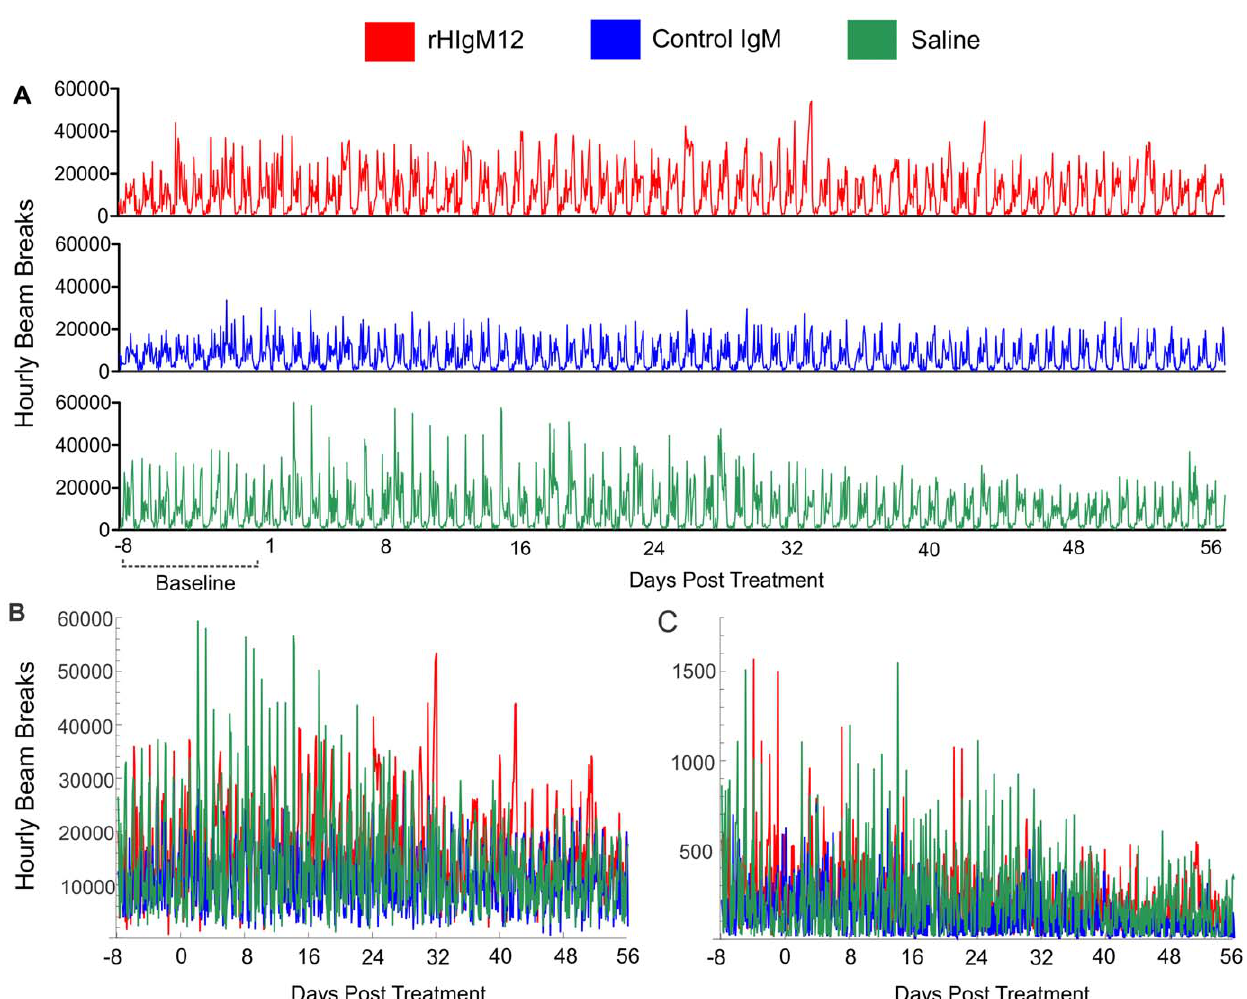
Figure 1. Example of spontaneous nocturnal activities of TMEV infected mice. A) Original complete recordings of horizontal activity over the period of 64 days. High nocturnal and low diurnal activities are easy to appreciate. Because mice are normally active during the night time we selected nocturnal activities for analysis (6PM-6AM). However, by visual inspection of unfiltered compressed recordings in either horizontal (B) or vertical (C) activity it may be difficult to identify real long-term changes.